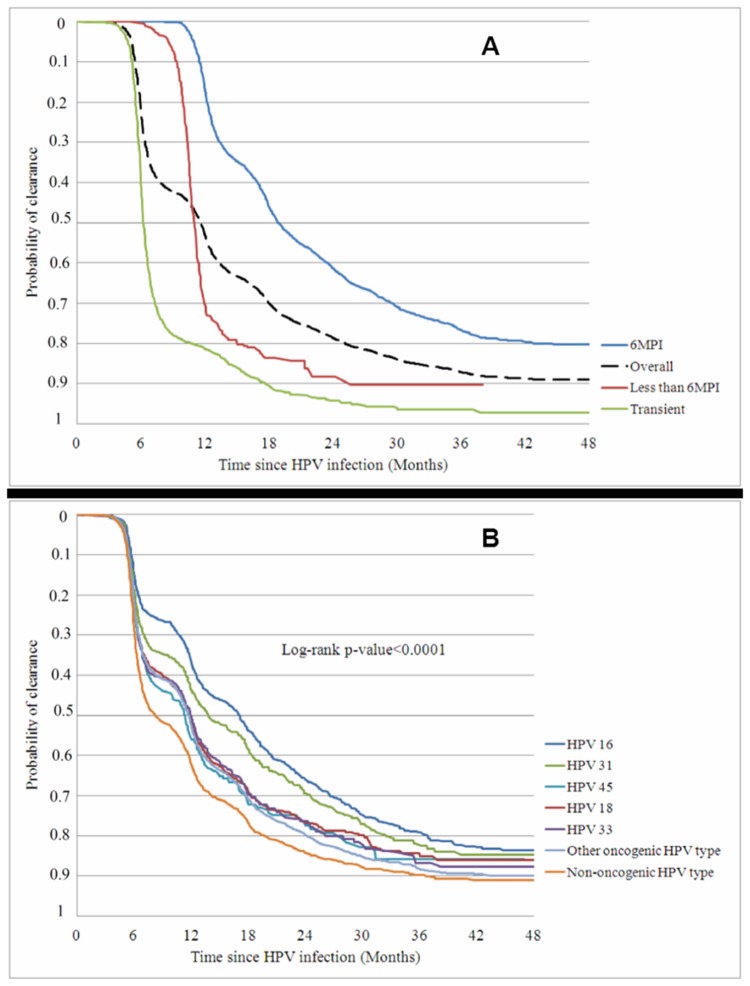
Cumulative chance of clearing a cervical HPV infection (prevalent and incident infections).
3a. Duration of infection

3b. HPV type (infection of any duration)
Kaplan–Meier estimates of probability of clearance (%) were calculated for transient, less than 6-month persistent HPV infection (6MPI), 6MPI and overall (Figure 3a) or according the HPV types (Figure 3b): HPV-16, HPV-18, HPV-31, HPV-33, HPV-45, other oncogenic HPV types and non-oncogenic HPV types.